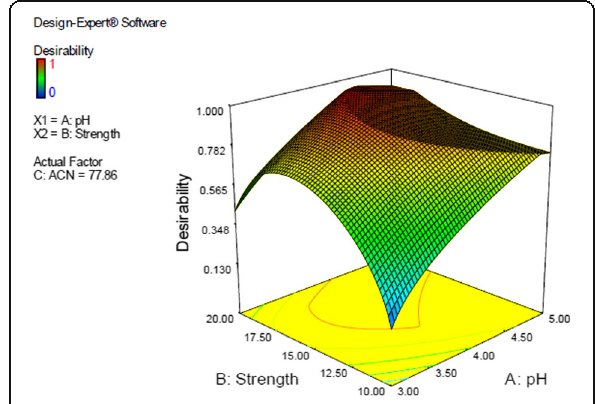
Fig. 2 Graphical representation of overall desirability function (D = 1), where A pH = 4.5, B ionic strength = 16.0 mM, and C perect acetonirile content = 77.0%